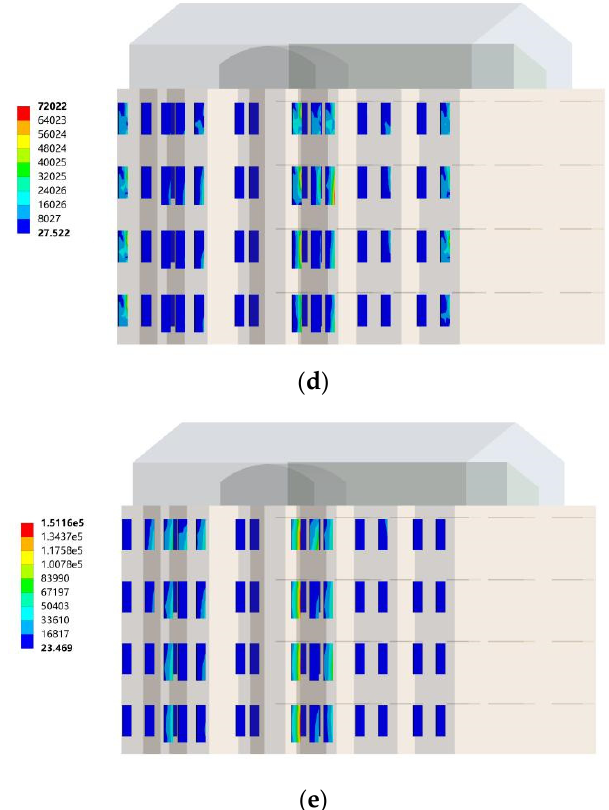
Figure 12. Northwest wind, where the northward vertical sun visors changed with the orientation of the building. ( a ) Cloud map of the sun visors in the south direction; ( b ) Cloud map of the sun visors in the direction of south by west 15; ( c ) Cloud map of sun visors in the direction of south by west 30; ( d ) Cloud map of the sun visors in the direction of south by east 15; ( e ) Cloud map of the sun visors in the direction of south by east 30.